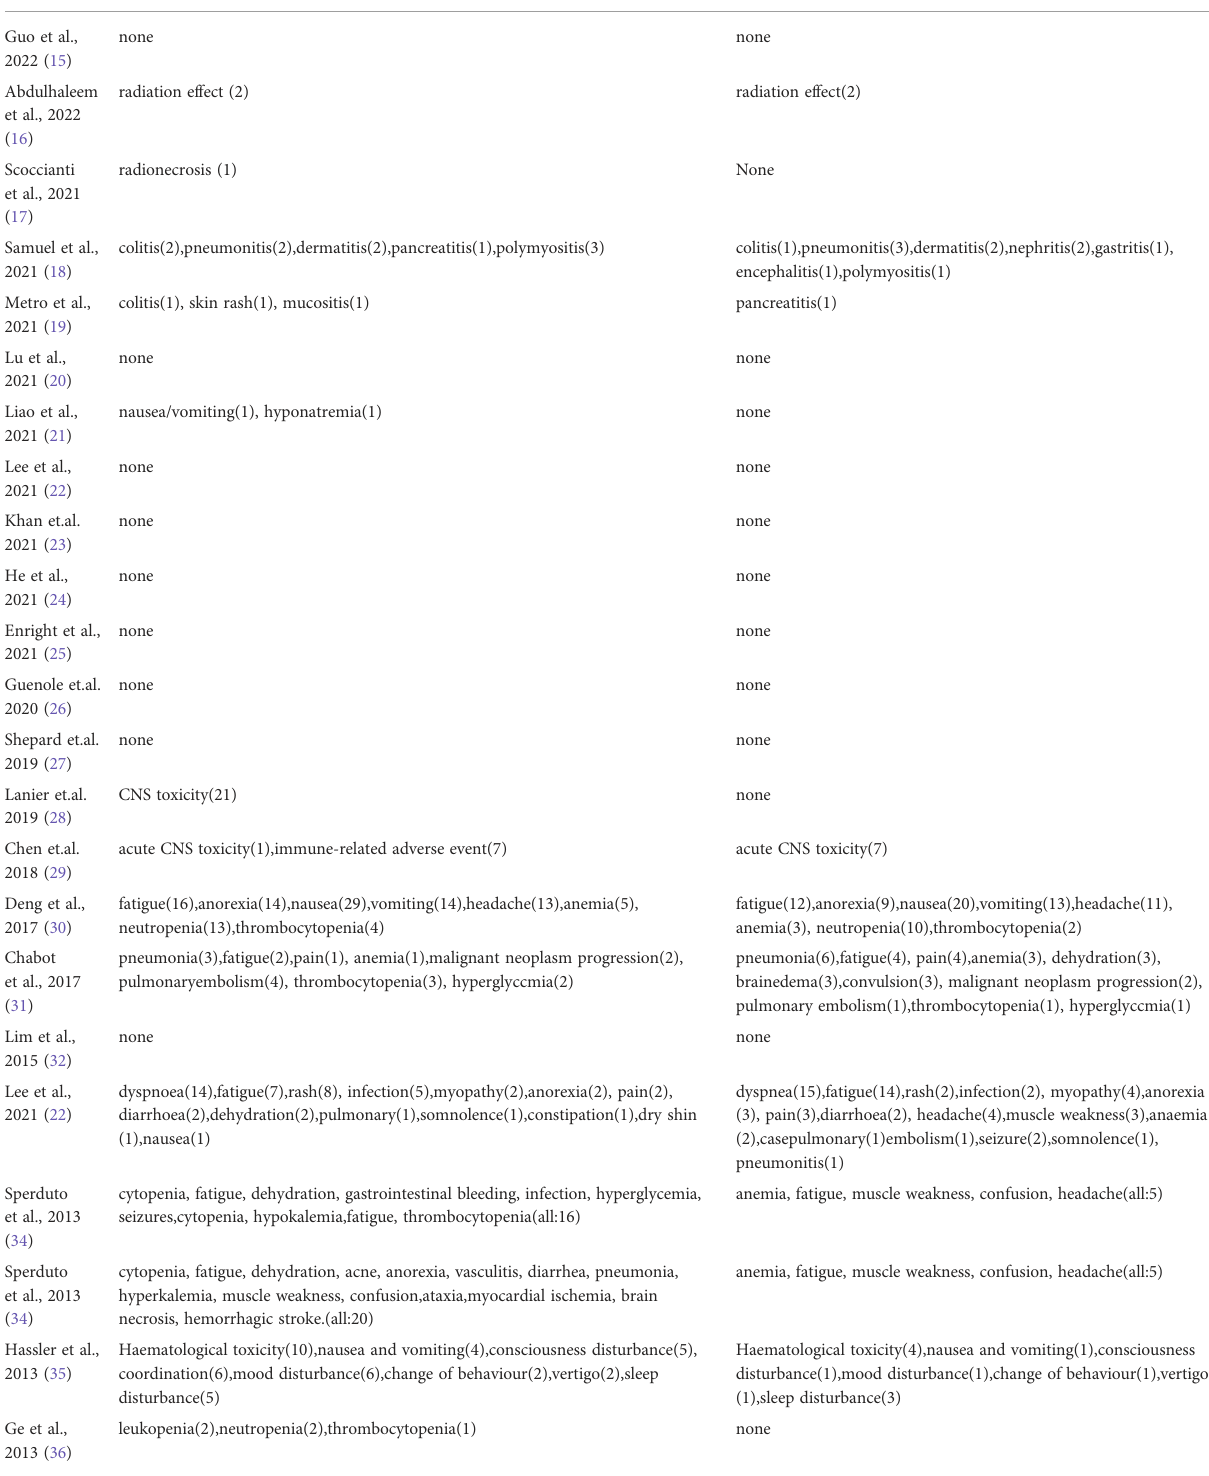
TABLE 3 Adverse